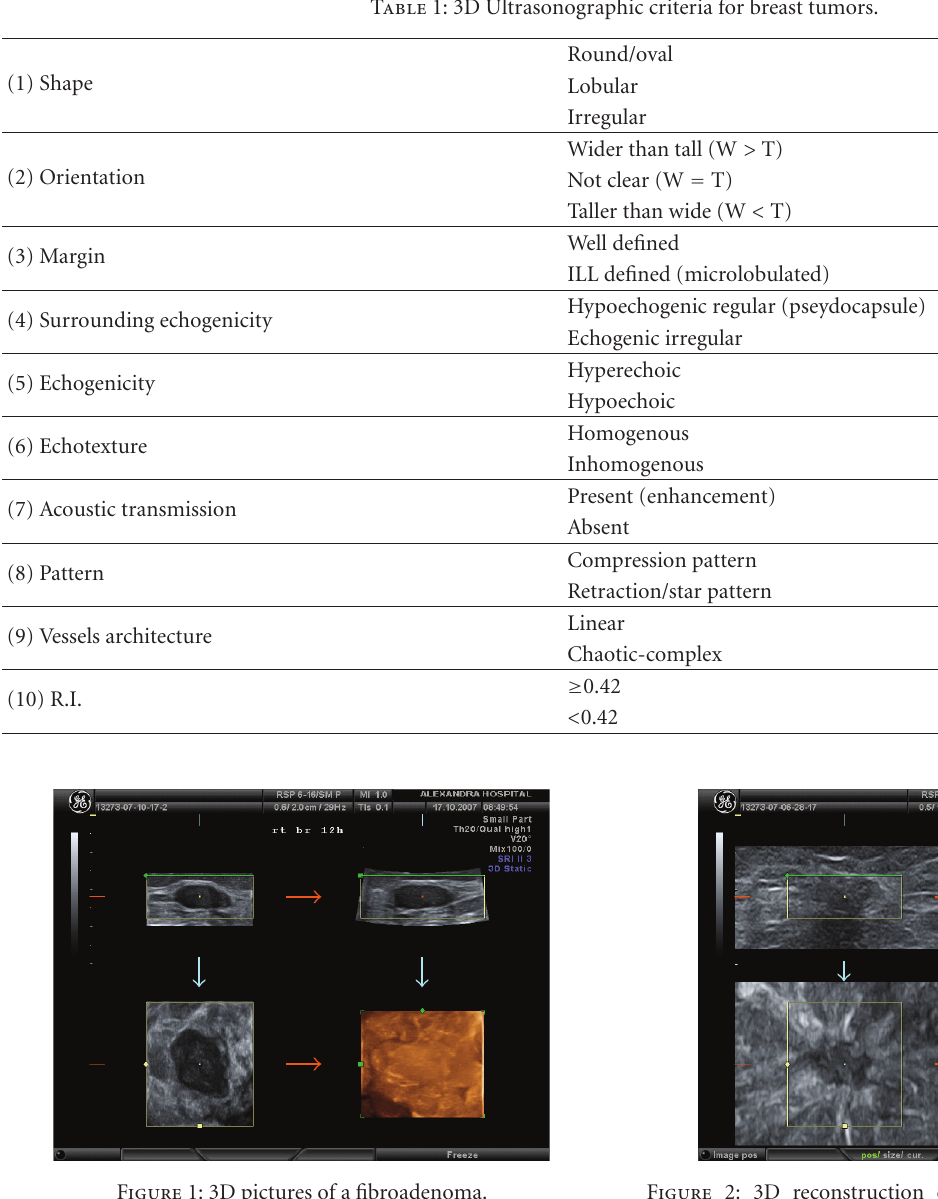
Table 1: 3D Ultrasonographic criteria for breast tumors.